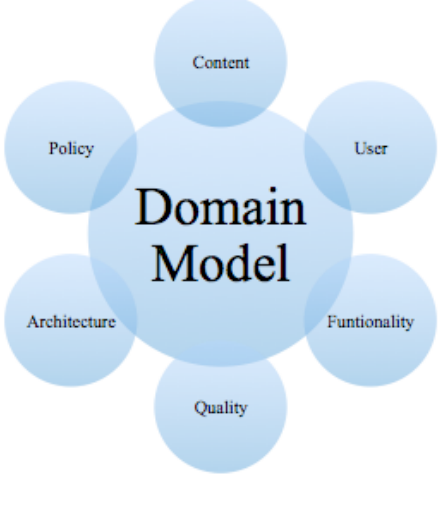
Figure 5. The Rock Art Domain